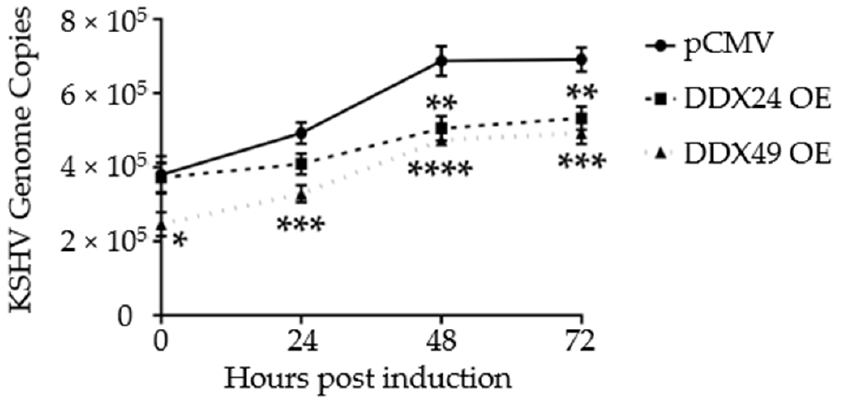
Figure 4. Intracellular KSHV genome copy number in BCBL-1 cells stably expressing DDX24-DDK, DDX49-DDK or empty pCMV vector during a 2 mM NaB induction time course. There was a statis-